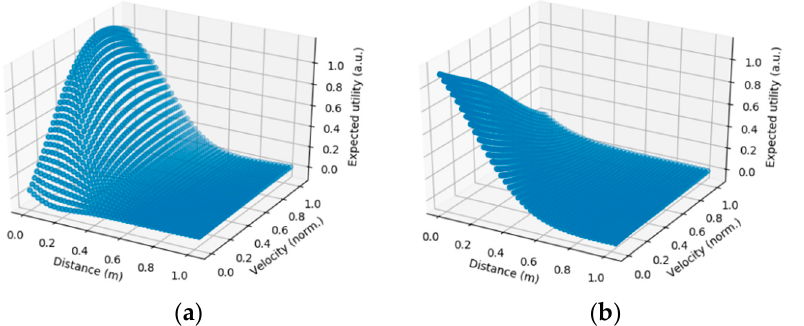
Figure 2. 3D representation of the skills learned in terms of distance and speed of the gripper. ( a ) VF associated to the push-object skill; ( b ) VF associated with the grabbing